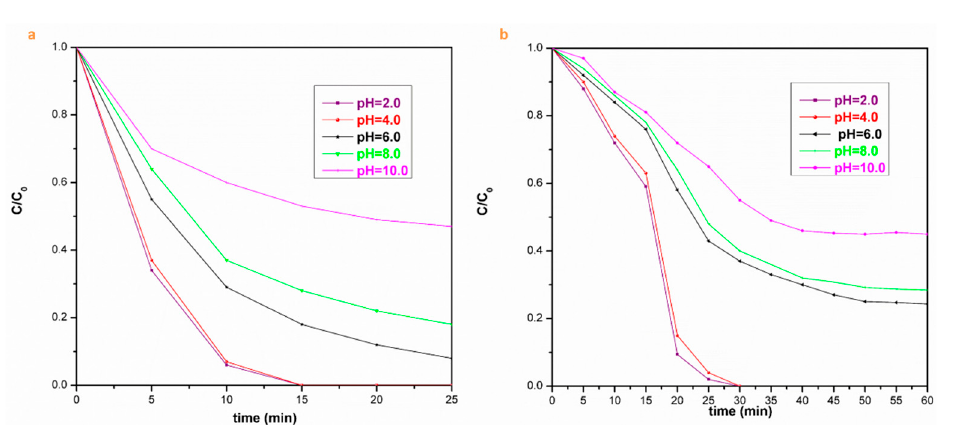
Figure 11. Effect of pH on the simultaneous removal of ( a ) Cr(VI) and ( b ) 4-CP by MFNNs. (Experiment conditions: [Cr(VI)] 0 = 10.0 mg/L, [4-CP] 0 = 100.0 mg/L, [MFNNs] = 0.20 g/L, [H 2 O 2 ] 0 = 4.90 mM).